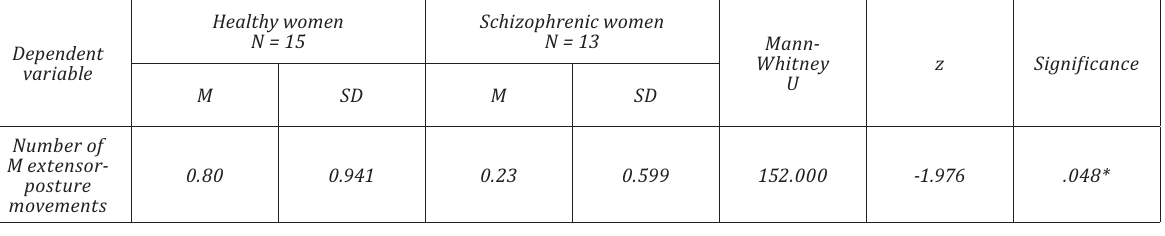
Table 1. Comparison of the groups of healthy and schizophrenic women in terms of one of the variables associated with M